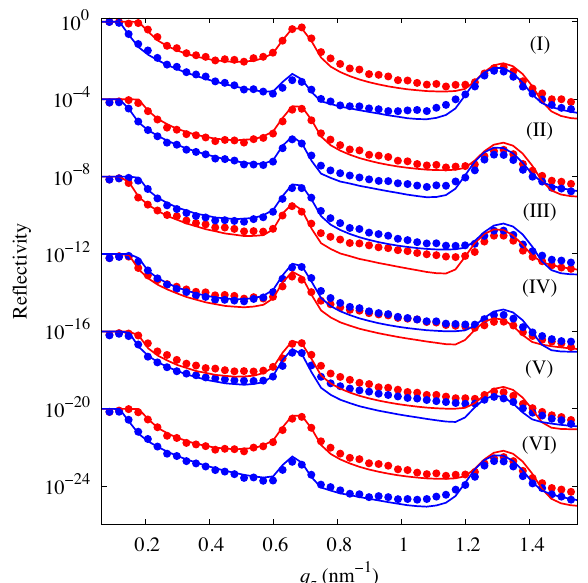
Figure 3. Polarized neutron reflectivity profiles of the Fe/Si multilayer. (I)–(VI) correspond to the measured conditions shown in Figure 2. R ++ and R −− are shown in red and blue. The symbols and lines indicate the measured and fitted reflectivities, respectively. Each profile is shifted vertically by four orders of magnitude relative to the profile for the immediately previous field for